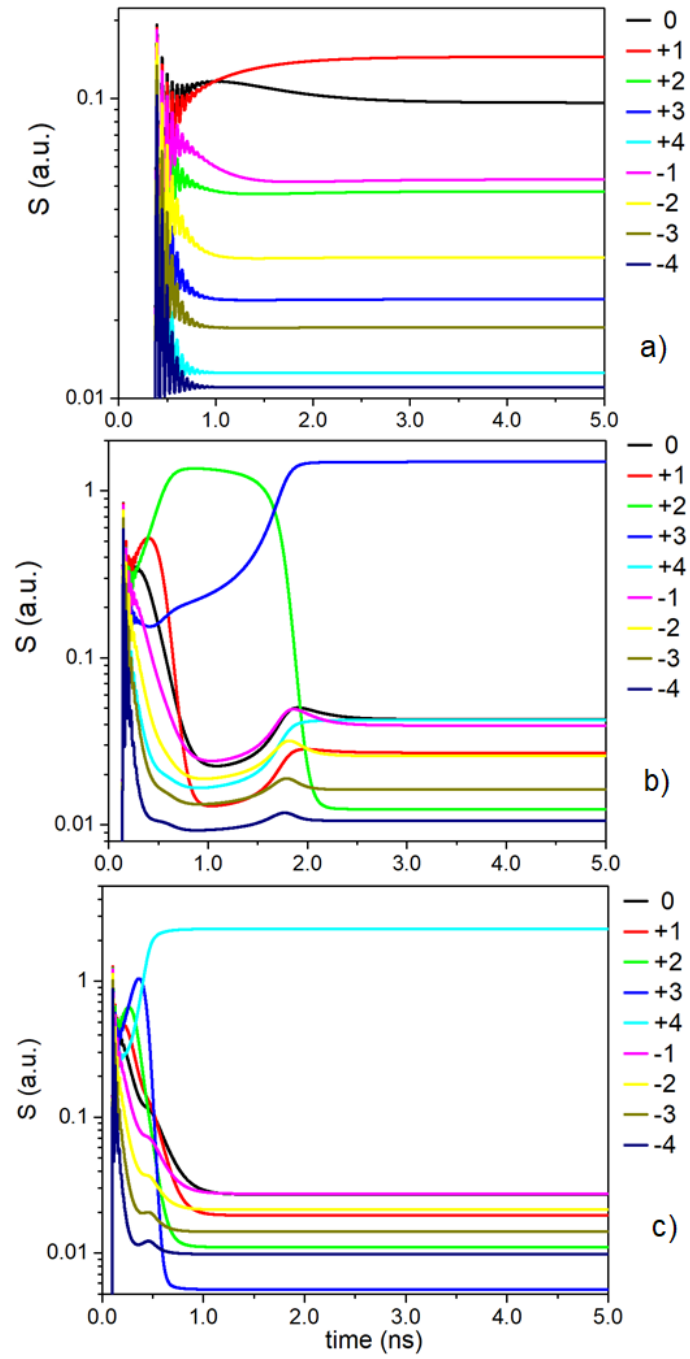
Figure 3. The time evolution of total output number S